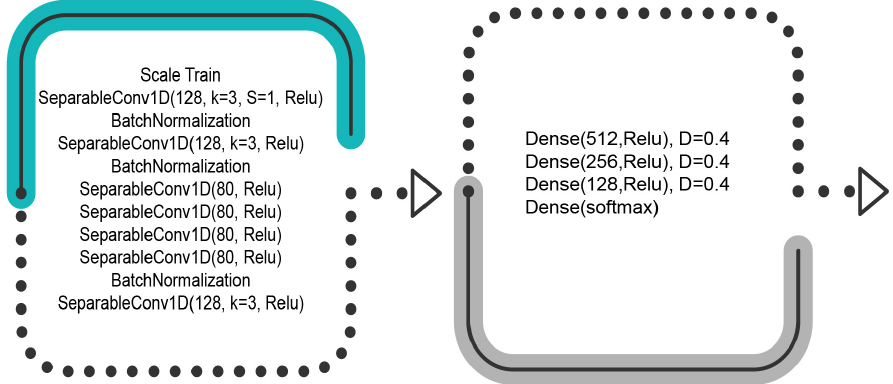
Figure 4. EEG neural network architecture configuration (Phyton TensorFlow